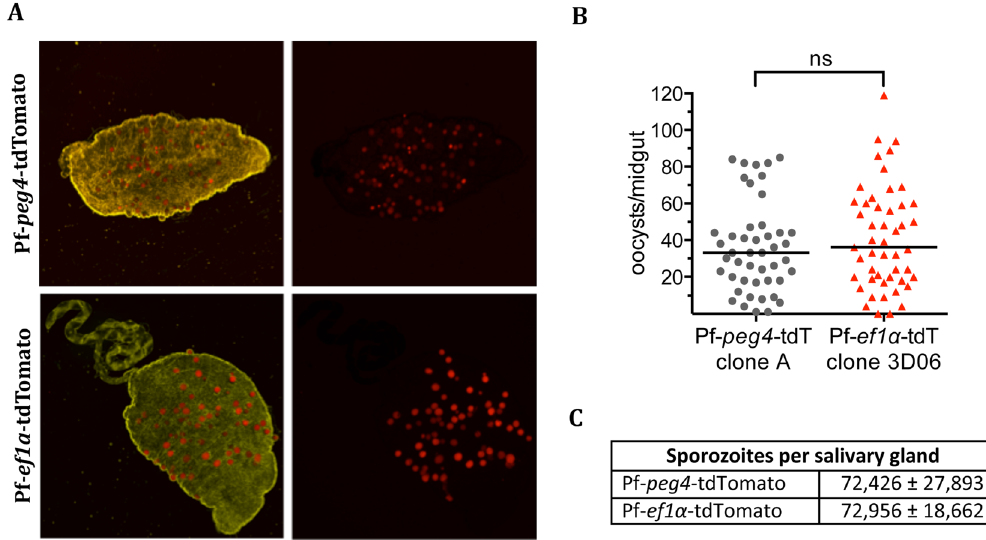
Figure 2. Passage through the mosquito of P . falciparum -tdTomato lines is normal. ( A ) Mosquito midguts (whitelight) were dissected 10 days after the infectious blood meal and imaged using fluorescence microscopy to visualize associated Pf- peg4 -tdTomato and Pf- ef1 α -tdTomato oocysts (red). ( B ) Oocysts were counted based on their tdTomato fluorescence and data from two independent feeding experiments each are shown. Horizontal line shows median oocyst number. Groups were compared using an unpaired t-test with equal standard deviations. ( C ) Pf- peg4 -tdTomato and Pf- ef1 α -tdTomato lines produce normal number of salivary gland sporozoites. Shown is the mean + / − standard deviation of salivary gland loads from 20